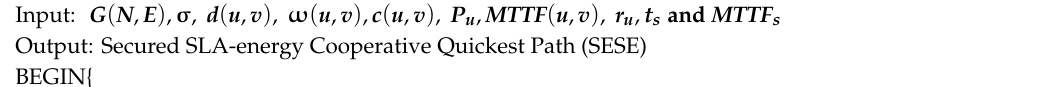
Algorithm 2: Secure, Energy- and SLA-E ffi cient (SESE) Algorithm with involvement of malicious